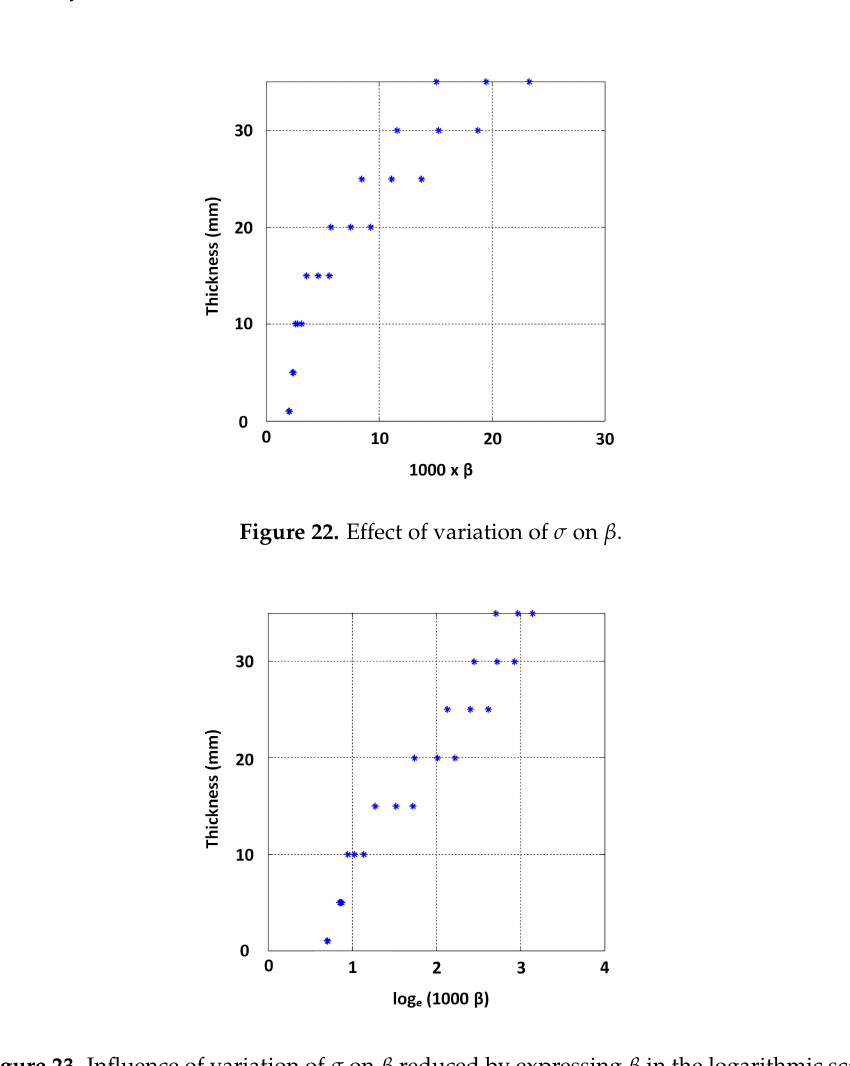
Figure 21. Signals simulated for 15 mm grey cast iron by varying electrical conductivity as per variation in conductivity observed in Section 3.1.